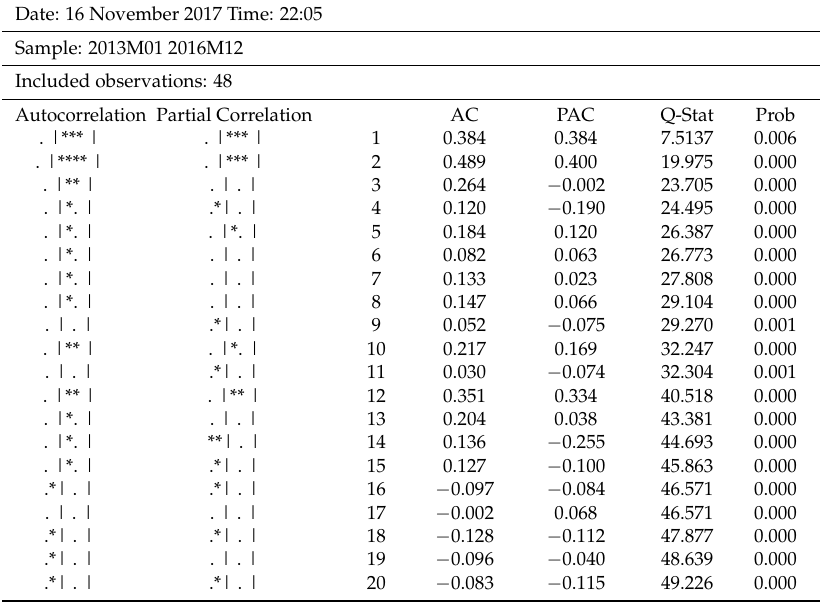
Table 5. Correlation analysis.